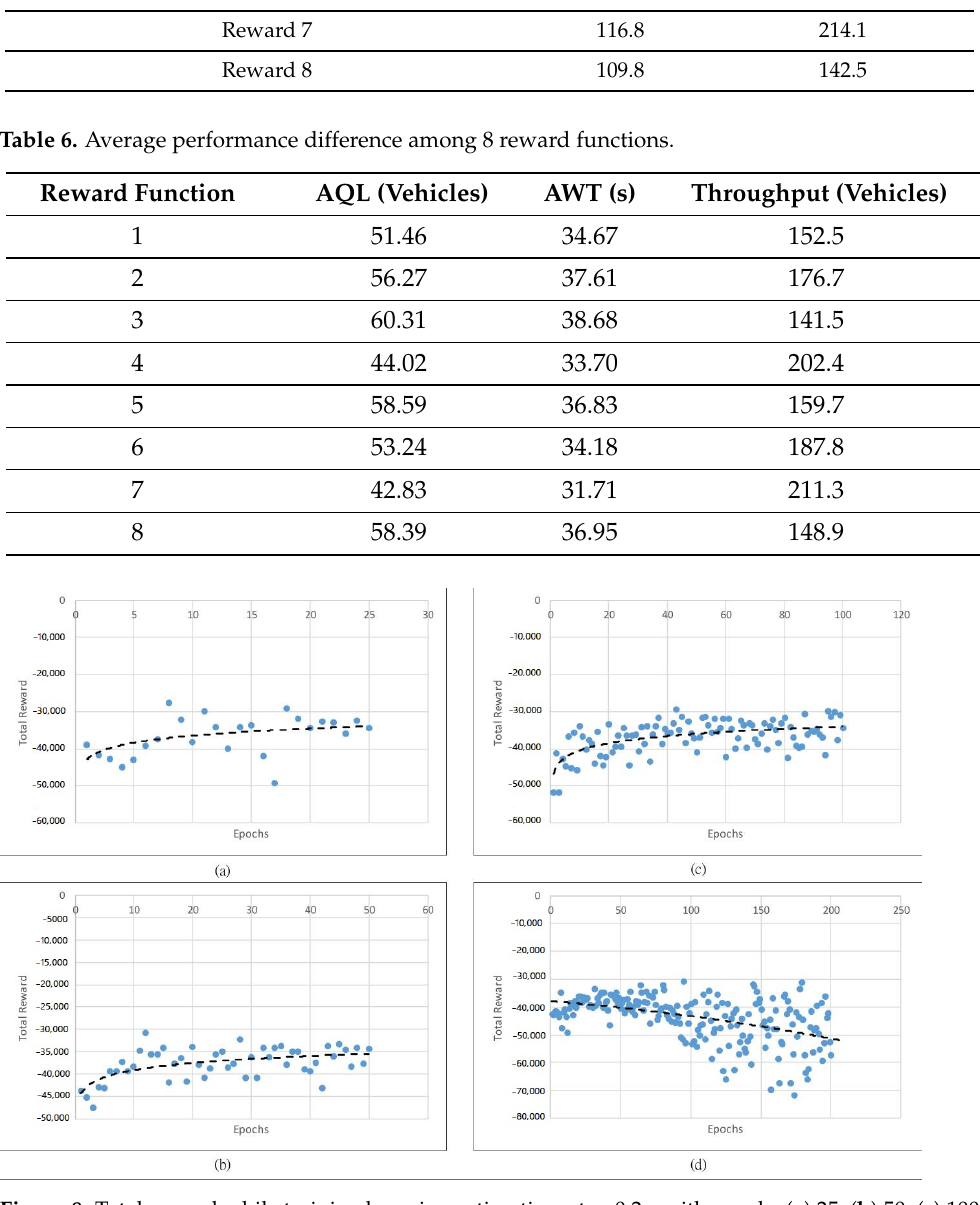
Figure 8. Total reward while training by using action time step 0.2 s with epochs ( a ) 25, ( b ) 50, ( c ) 100, and ( d )